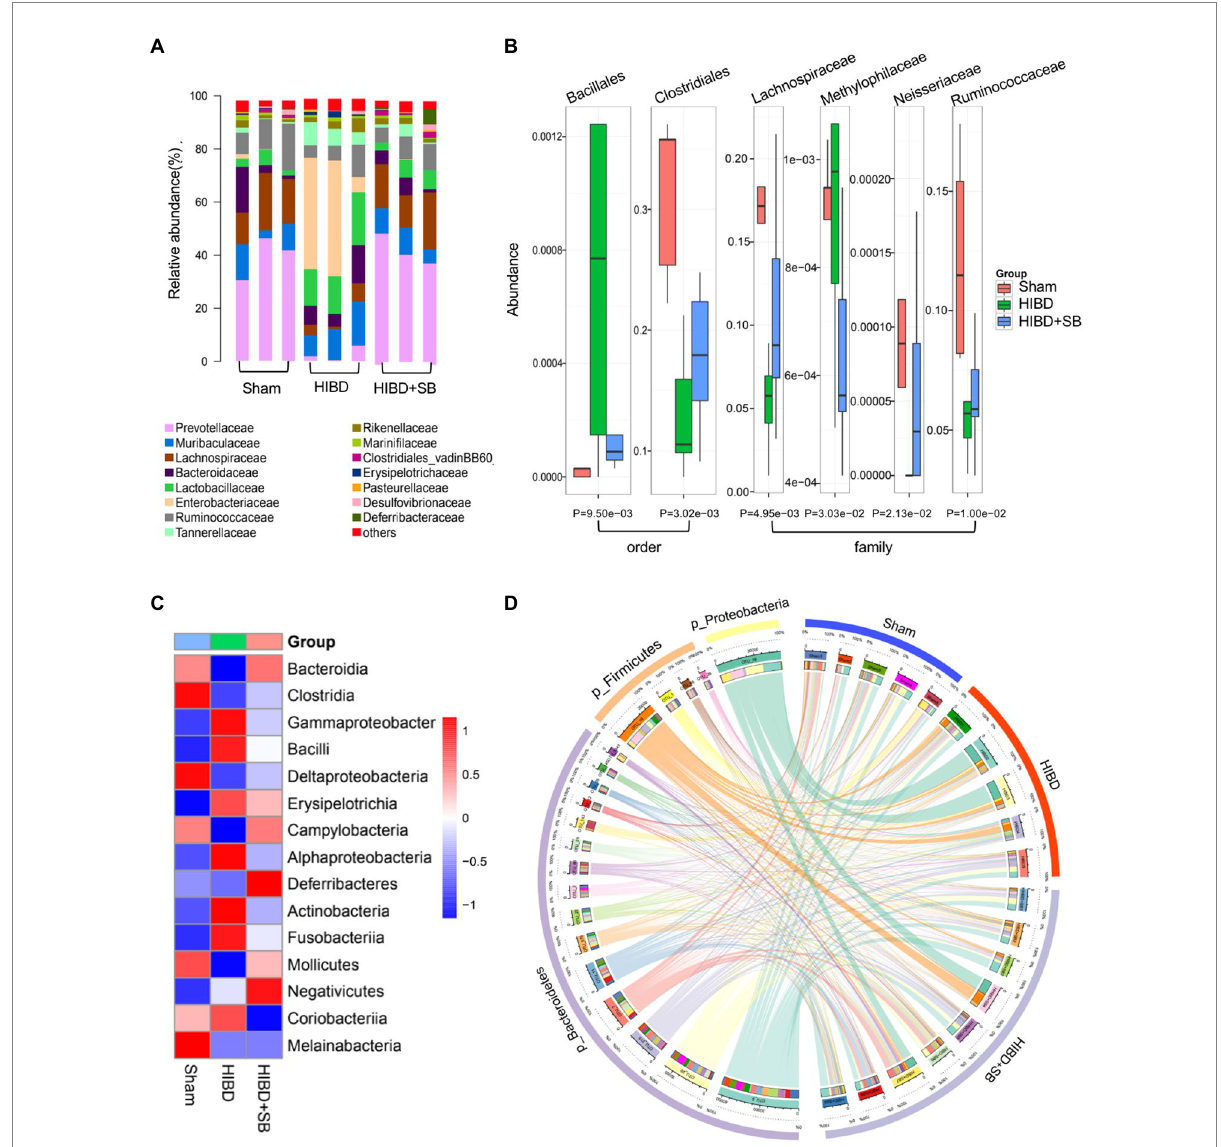
FIGURE 5 ( A ) Taxonomic summary of the gut microbiota species between the Sham, HIBD and HIBD + SB group at family level. Each column represents a sample, different colors represent different annotation information, and the ordinate represents the relative abundance ( n = 3 per group). ( B ) The Boxplot of microbiota between groups at order and family level, different colors represent different groups of samples, and the ordinate represents the relative abundance value of species, the bottom label is p value ( n = 5 in Sham and HIBD group, n = 8 in HIBD + SB group). ( C ) Heat map of microbiota species at class level, red indicates high relative abundance of species, blue indicates low relative abundance of species ( n = 5 in Sham and HIBD group, n = 8 in HIBD + SB group). ( D ) The outer circle and inner circle of the left semicircle represent the species information at phylum level with Top5 abundance and their proportions in different groups, respectively. The outer and inner circles of the right semicircle represent the sample grouping information and the proportion of species contained at the Top5 phylum